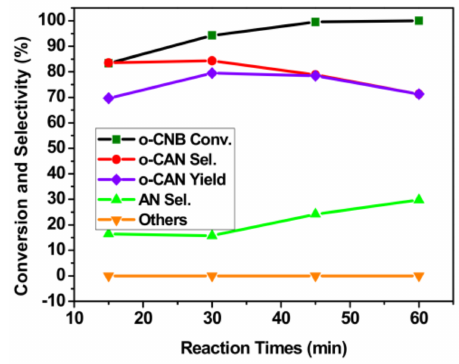
Figure 8. Effects of reaction time on the o -CNB hydrogenation over 0.2%Pd/NiO catalyst. Conditions: 60 ◦ C, P (H 2 ) = 1 MPa, m cat. = 20 mg, n o -CNB /n Pd = 9000:1, V ethanol = 5 mL.